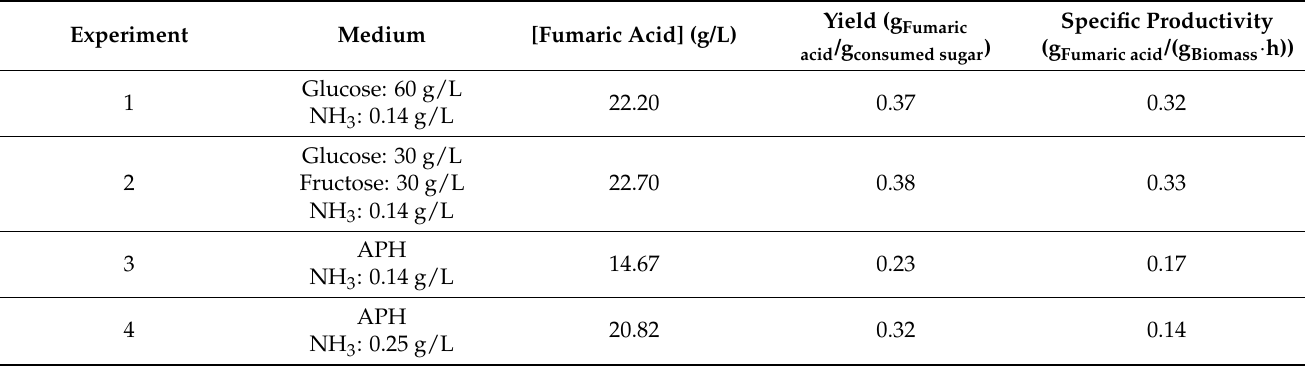
Table 2. Main parameters of the experiments performed in this